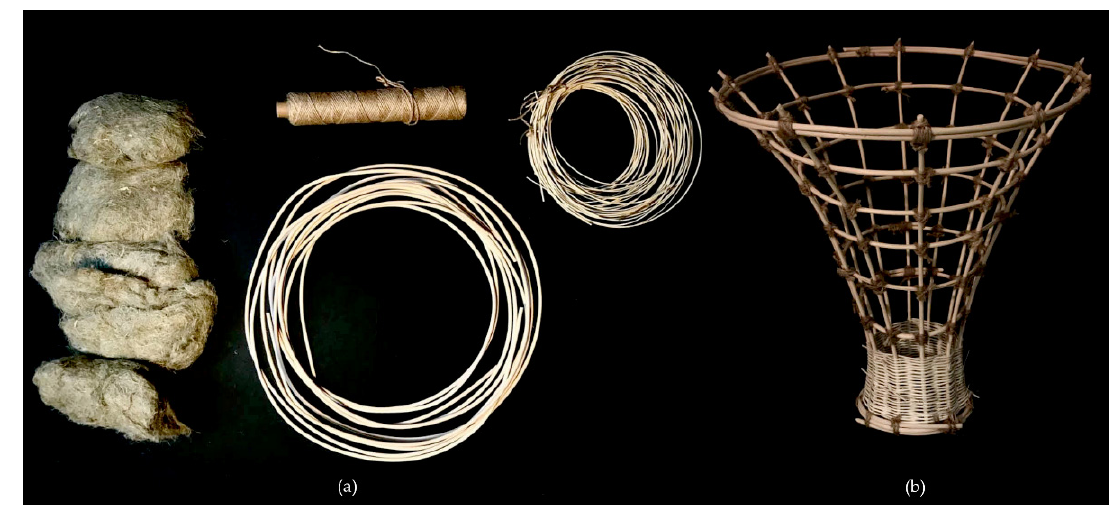
Figure 11. Material overview: ( a ) hemp fibers, rattan rods, jute fabric, ( b ) assembled rattan frame.